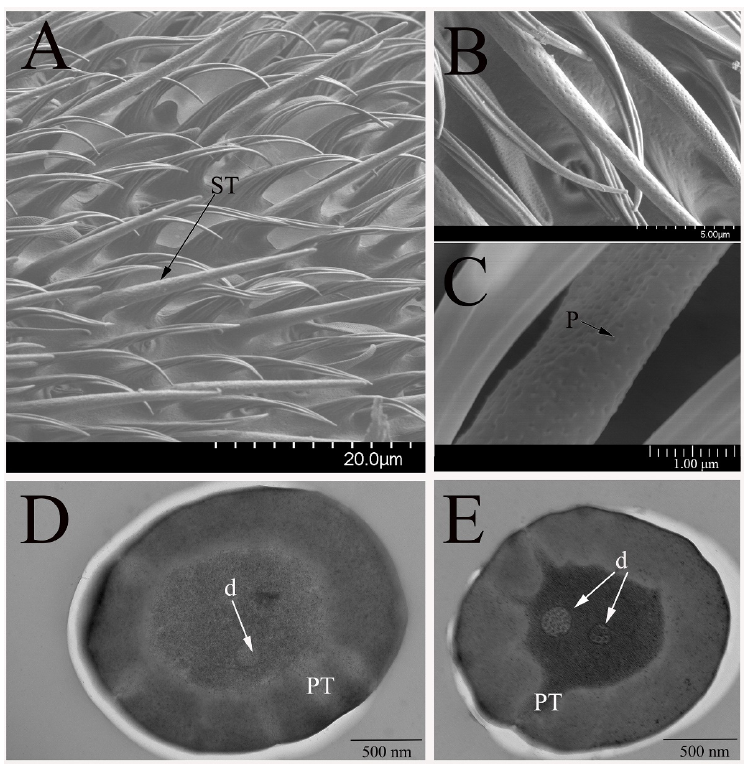
Figure 2. Sensilla trichodea (ST) on B. dorsalis antenna. ( A ) The regular array of ST on male adult antennal funiculus. ( B ) Higher magnification of shaft surface of ST on male antennae. ( C ) Showing the ultrastructure of the high density distributed tubular pores (P) on the cuticle surface. The ultra- structure of ST on female antennae is similar to that of male antennae. ( D ) ST subtype I (ST-I) con- tains one dendrite (d). ( E ) ST subtype II (ST-II) contains two dendrites. The numerous pores on the cuticle surface and the pore tubules are surrounded by the sensillum lymph. From the TEM images, the cuticular wall of both sensilla basiconica is 90–110 nm thick and contains pores of 37–41 nm width. The pores of SB are connected to the sensil- lum lumen through tubules. In cross-section analyses of sensillum structure, either two or four receptor cells innervate AnSB, producing various types of numbers of dendrites (Fig- ure 3D,E), which may divide into many dendritic branches (Figure 3F) within each sensil- lum. The neuron dendritic branch is restricted to a small region of the sensillum, namely the structure that is like a brush (Figure 3B). The outer dendritic segment appears as one dendrite at the basal part of the sensillum (Figure 3C). Some of the SB exhibited lamellate dendritic branches (Figure 4B), whereas others showed varying sizes of circular dendritic branches (Figure 3F).